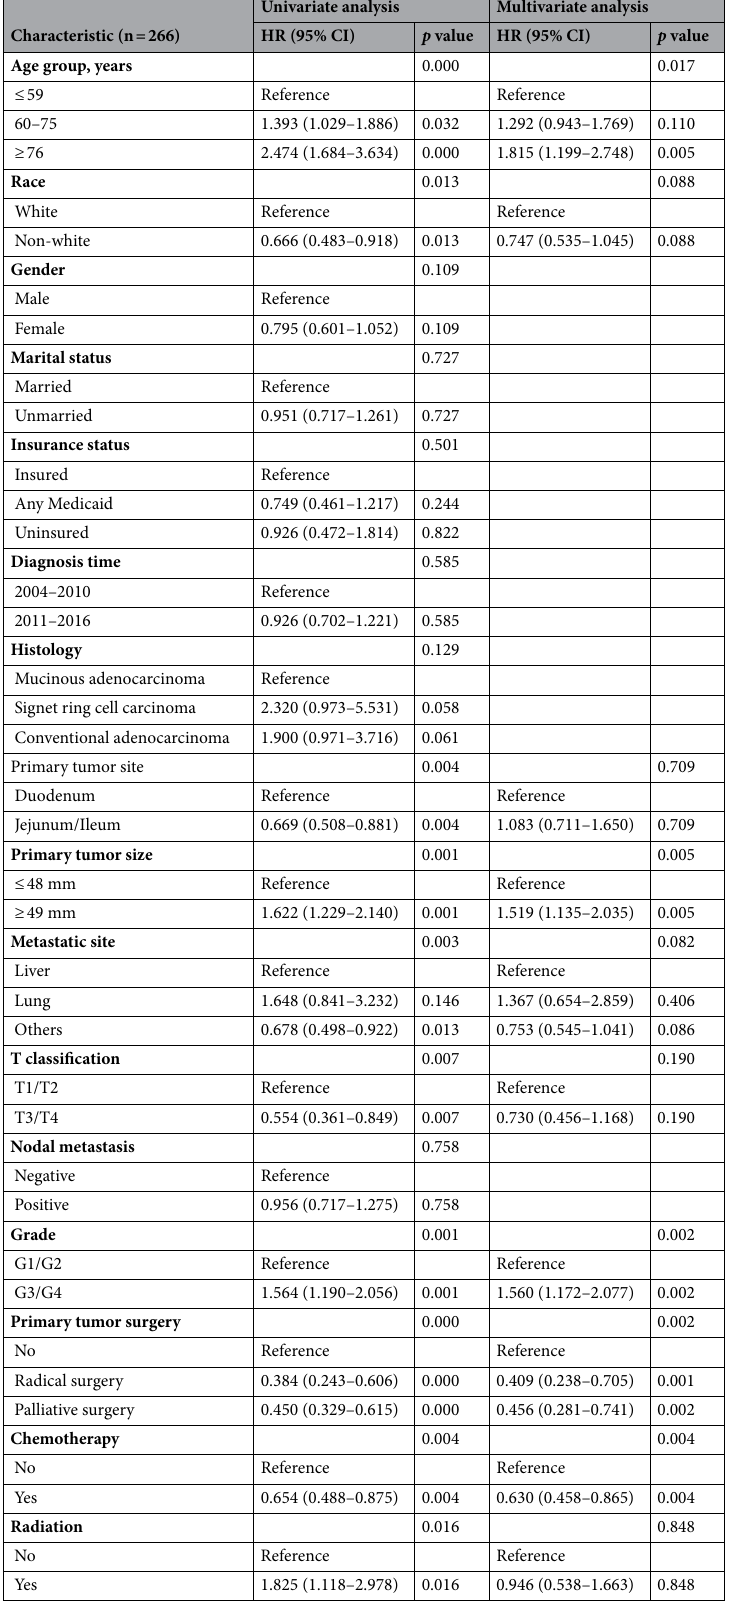
Table 2. Univariate and multivariate analyses of overall survival for the training cohort. Others*: bone, brain, distant lymph node, and other sites; HR, hazard ratio; CI, confidence